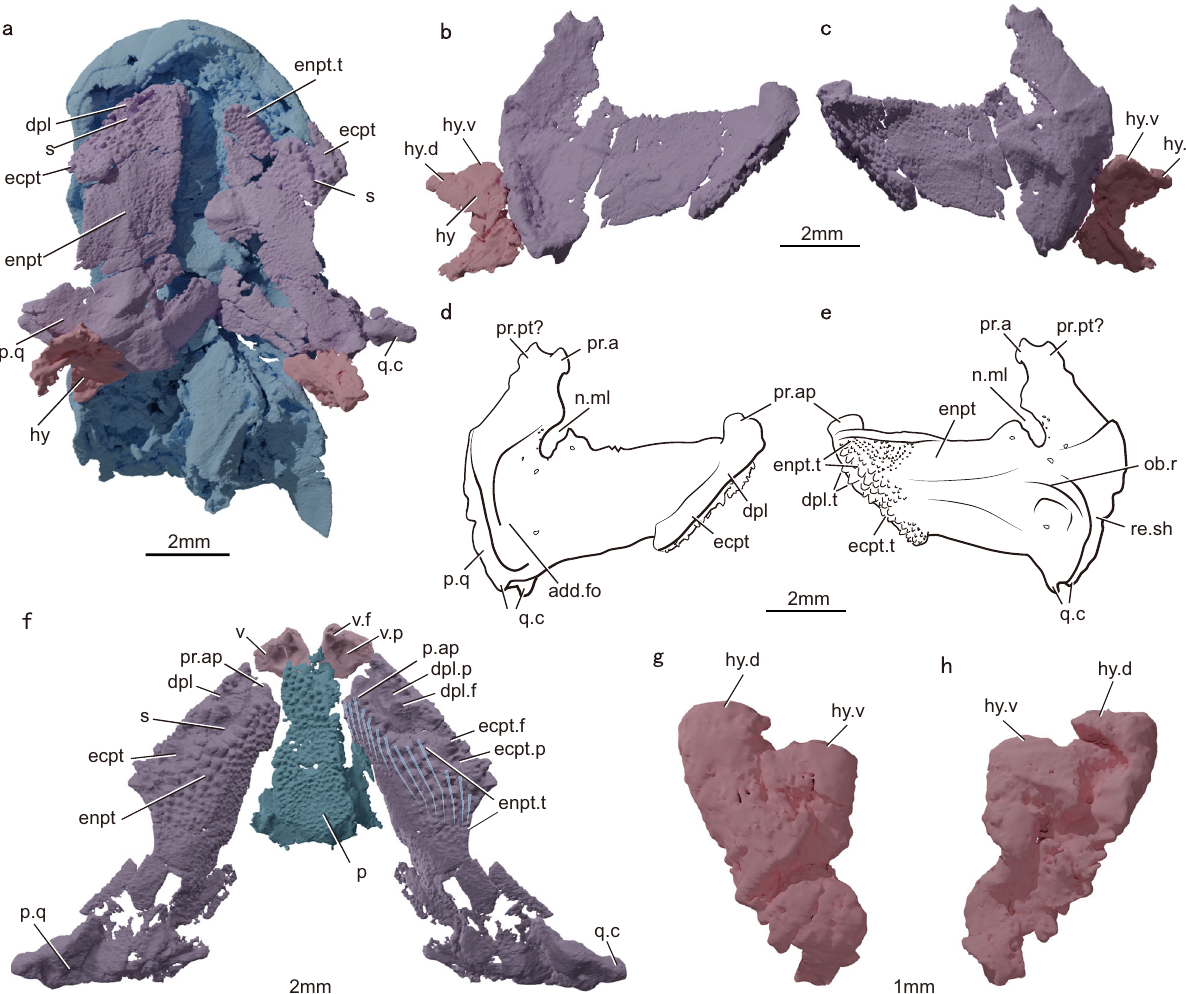
Fig. 2 The palate and dorsal portion of the hyoid arch of Youngolepis praecursor . a Virtual rendering of IVPP V28375 in ventral view showing palate and hyoid arch preserved in situ. b , c Virtual rendering of right palatoquadrate complex and hyomandibula of V28375 in lateral ( b ) and medial ( c ) view. d , e Interpretive drawing of right palatoquadrate complex of V28375 in lateral ( d ) and median ( e ) view. f Virtual rendering of palatoquadrate complex, vomer, and parasphenoid of V28376 in ventral view; palatoquadrate complex and vomer mirrored and restored to approximate life position. g , h Virtual rendering of right hyomandibula of V28376 in lateral ( g ) and median ( h ) view. add.fo adductor fossa, dpl dermopalatine, dpl.f dermopalatine fang, dpl.p dermopalatine fang replacement pit, dpl.t dermopalatine teeth, ecpt ectopterygoid, ecpt.f ectopterygoid fang, ecpt.p ectopterygoid fang replacement pit, ecpt.t ectopterygoid teeth, enpt entopterygoid, enpt.t entopterygoid teeth, hy hyomandibula, hy.d dorsal head of hyomandibula, hy.v ventral head of hyomandibula, n.ml notch for ramus of maxillaris and mandibularis, ob.r oblique ridge, p parasphenoid, p.ap pars autopalatina, p.q pars quadrata, pr.a ascending process, pr.ap autopalatine process, pr.pt? paratemporal process, q.c quadrate condyle, re.sh spiraculo-hyomandibular recess, s suture, v vomer, v.f vomerine fang, v.p vomerine fang replacement